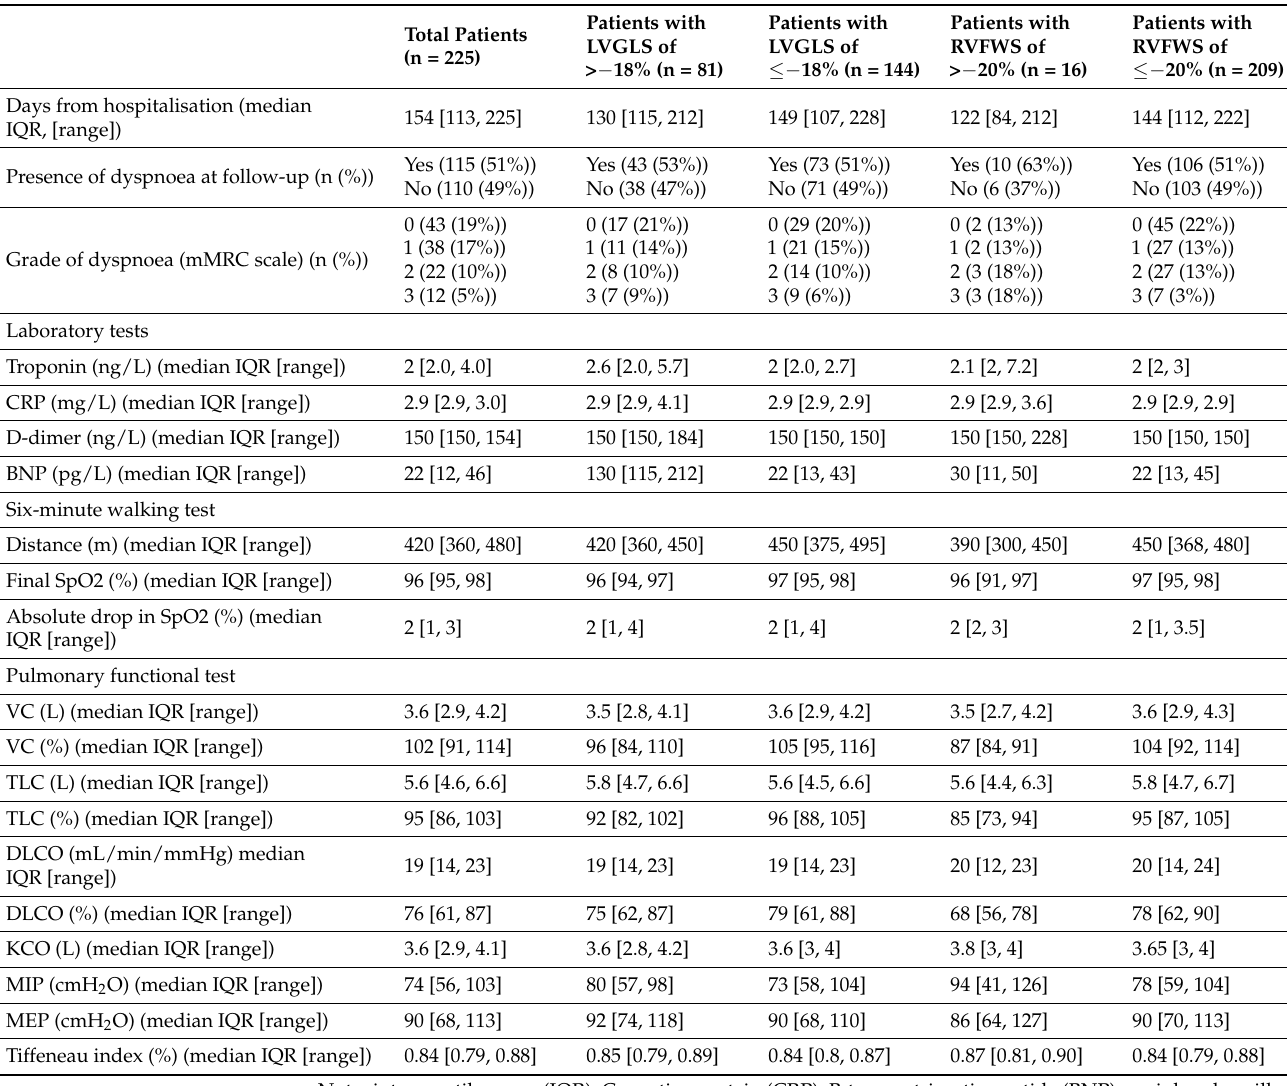
Table 2. Characteristics at the first follow-up visits (clinical and instrumental evaluations), with differences between the patients with and without subclinical injuries. Patients with Patients with Patients with Patients with Total Patients LVGLS of LVGLS of RVFWS of RVFWS of (n = 225) ≤− 18% (n = 144) ≤− 20% (n = 209) > − 18% (n = 81) > − 20% (n = 16) 154 [113, 225] 130 [115, 212] 149 [107, 228] 122 [84,